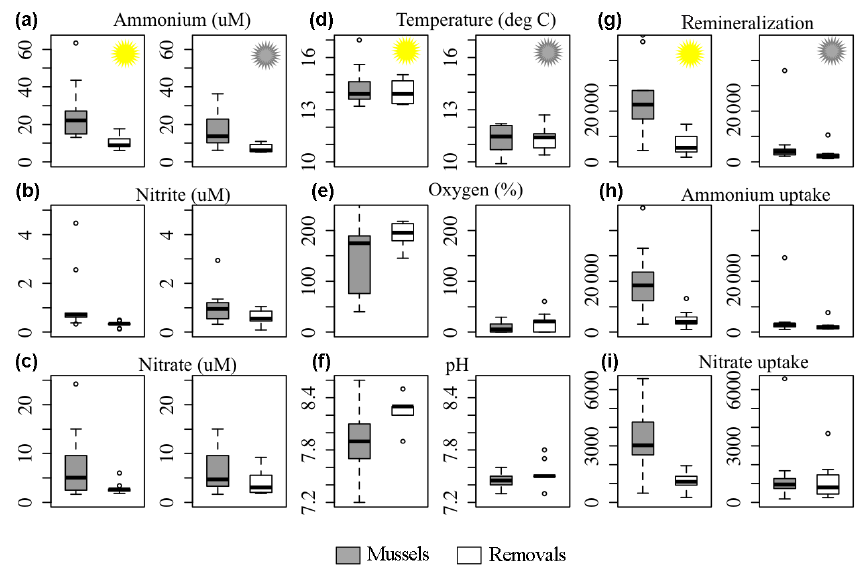
Figure 2. The ending measured concentrations (in µM) for ammonium, nitrite and nitrate and the ending seawater temperature ( ◦ C), percent oxygen and pH in all experimental tidepools used for the linear mixed effects model results in Table 2. The right three panels are rates (nmolL − 1 h − 1 ) estimated from the ODE model (Eqs. 2–7), including the estimated rate of remineralization ( m) and ammonium and nitrate uptake rates in experimental tidepools. The dark horizontal line is the median, the box encompasses 50% of the data and the unfilled circles are outliers. The positive effect of mussels (shaded bars) on these three rates was greatest during the day. Linear mixed effects model results are in Table 4.